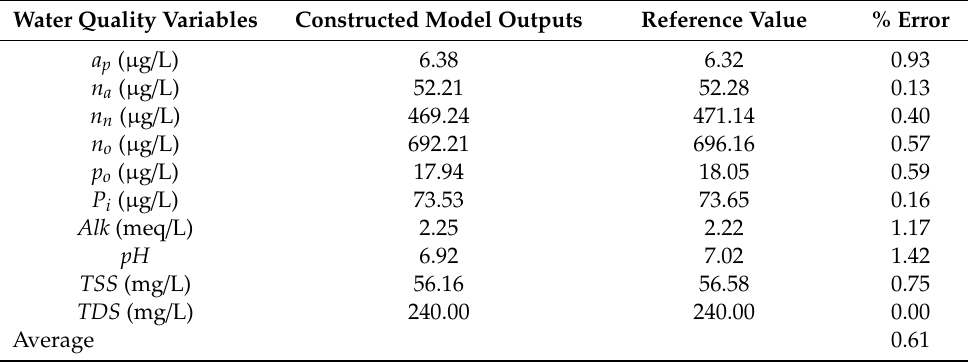
Table 6. Calibration with Qual2k for bed width 5 m.